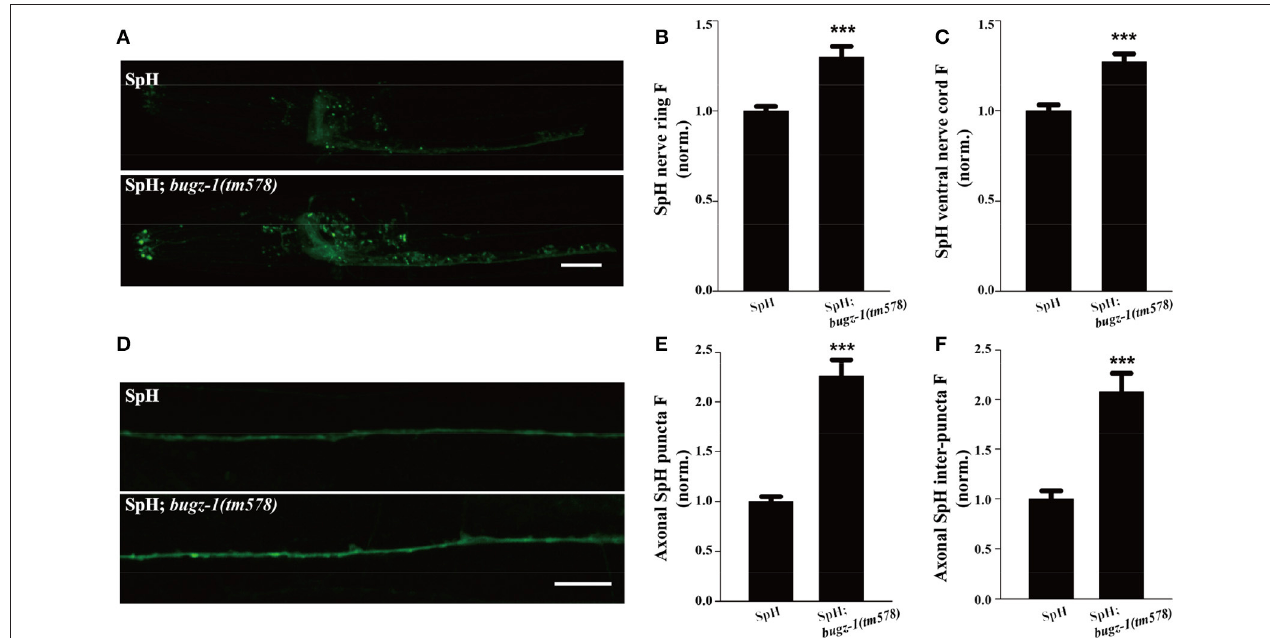
FIGURE 6 | bugz-1(tm578) show synaptic vesicle endocytosis defect. (A) Representative images of SNB-1::pHluorin (SpH) in the nerve ring and ventral nerve cord in wild type and bugz-1(tm578) mutant animals. (B,C) Quantification of fluorescence in the nerve ring (B) and ventral nerve cord (C) of bugz-1(tm578) mutant normalized to the wild-type control. n ≥ 14. (D) Representative images of SpH in the dorsal nerve cord in wild type and bugz-1(tm578) mutant animals. (E,F) Quantification of axonal puncta fluorescence (E) and inter-puncta fluorescence (F) of dorsal nerve cord in mutant normalized to the wild-type control. n ≥ 7. Values that significantly differ from controls are indicated (*** p < 0.001 by two-tails Student’s t -test). Error bars represent SEM. Scale bars indicate 10 µ m in (A) and 20 µ m in (D)